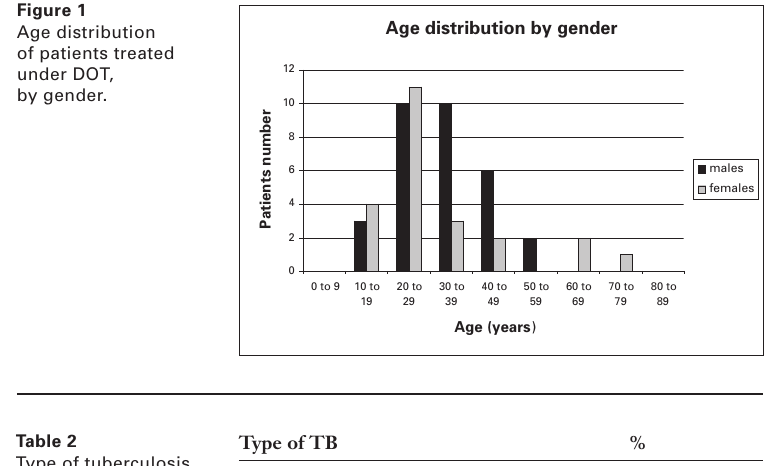
among 54 patients under